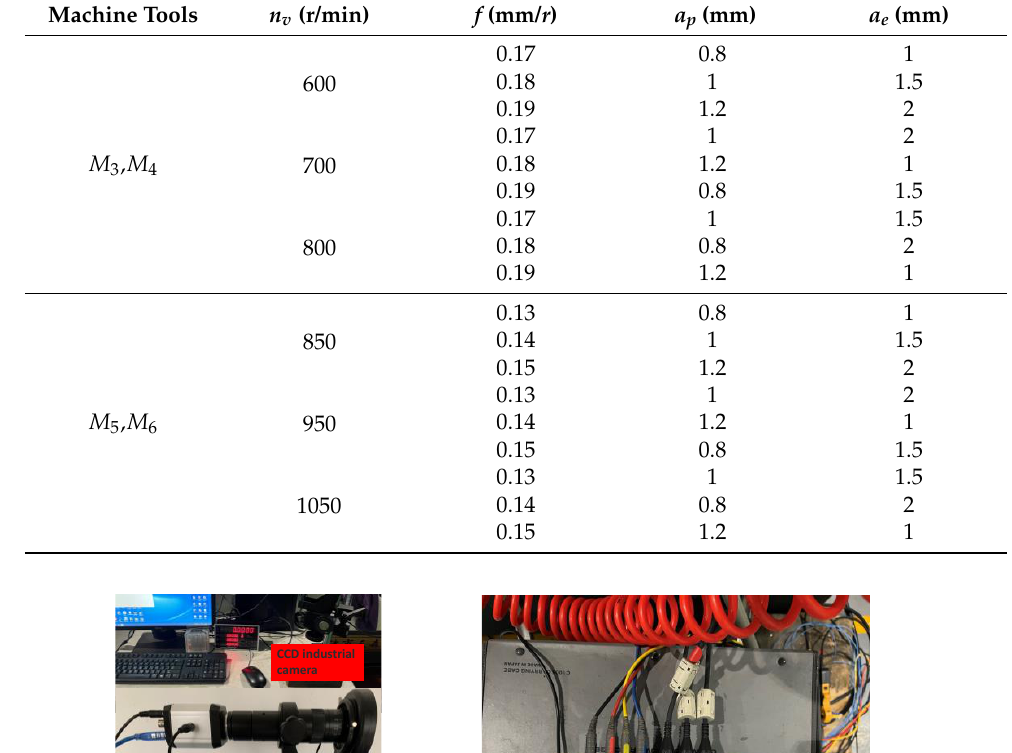
Figure 15. The tool cutting path.